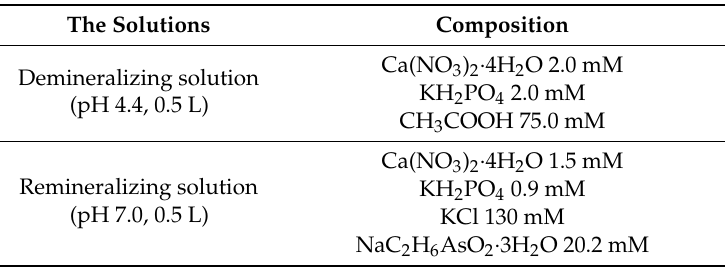
Figure 2. Remineralization length analysis method. ( a ) Microcomputer tomography CT slice of the region of interest (ROI) at the center of the lesion perpendicular to the enamel surface. The starting point was the end of the adhesive, the green line is the line separating the ROI from a reference point on the enamel surface. ( b ) Histogram from the ImageJ software program. The blue arrow indicates up to a level of 87% gray value from the reference point, the red arrow indicates the distance to the 87% gray value from the reference point. Table 2. Composition of demineralizing and remineralizing solution.